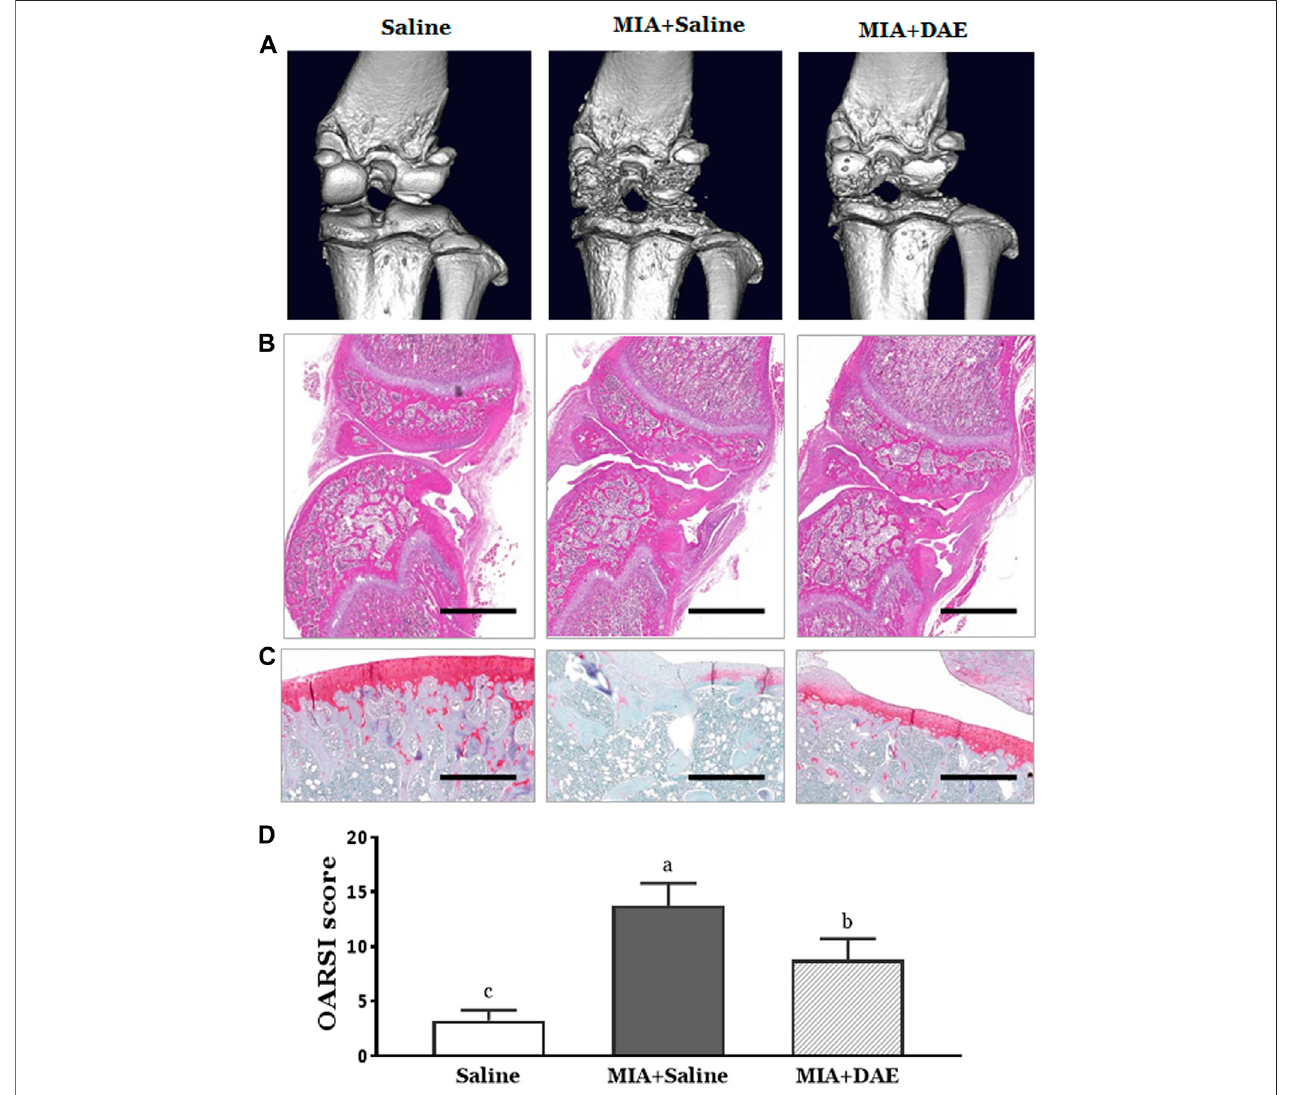
FIGURE3| Effectsof Dipsacusasperoides ethanolicextract(DAE)onmicro-computedtomography(micro-CT)imagesandhistopathologicalfeaturesofkneejoint lesions in rats with monosodium iodoacetate- (MIA-) induced osteoarthritis. (A) Representative in vivo micro-computed tomography images of a knee joint. Representativephotographsofkneejointsectionsstainedwith (B) H&E(scalebars (cid:2) 2,000 μ m)and (C) safraninO-fastgreen( × 100magni fi cation,scalebars (cid:2) 500 μ m) and (D) OARSIscoresofcartilagedestruction( n (cid:2) 3pergroup).Dataareexpressedasmean ± SD( n (cid:2) 3pergroup).Themeanofeachgroup(labeledwithlettersa, b, and c) wassigni fi cantly different, asdetermined byone-way analysis ofvariance (ANOVA) followed byDunnett ’ smultiple comparison test ( p < 0.05).Saline, rats given saline (vehicle); MIA + Saline, rats injected with MIA and given saline; MIA + DAE, rats injected with MIA and given DAE. OARSI, Osteoarthritis Research Society